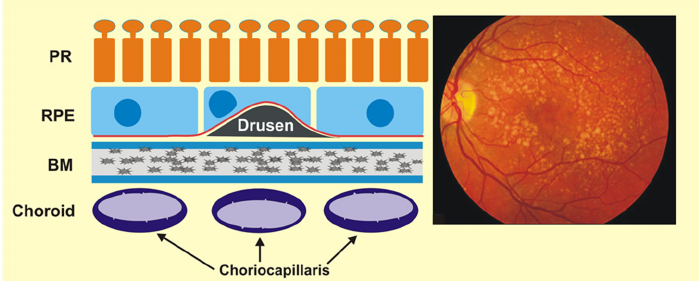
Figure 4. Drusen are extracellular waste located between retinal pigment epithelium (RPE) cells and Bruch’s membrane (BM), which can disturb forward vision. They are clearly visible in fundus fluorescence as scattered light stains. PR—photoreceptors.